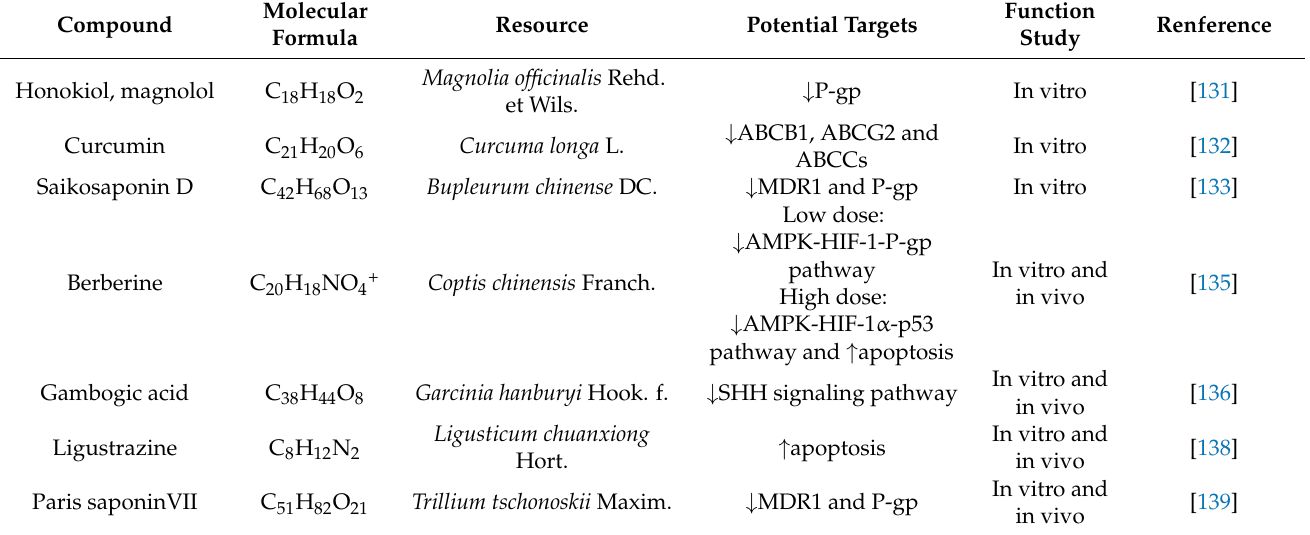
Table 1. Chinese medicine reversal agents for breast cancer and their mechanism of